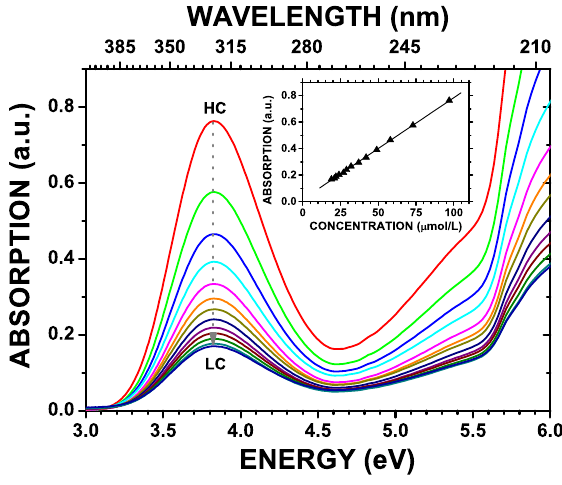
Figure 1. UV-vis optical absorption spectra of benznidazole in water for concentrations of 146.0 (HC), 97.3, 73.0, 58.4, 48.7, 41.7, 36.5, 32.4, 29.2, 26.5, 24.3, 22.5, 20.9, and 19.5 (LC)